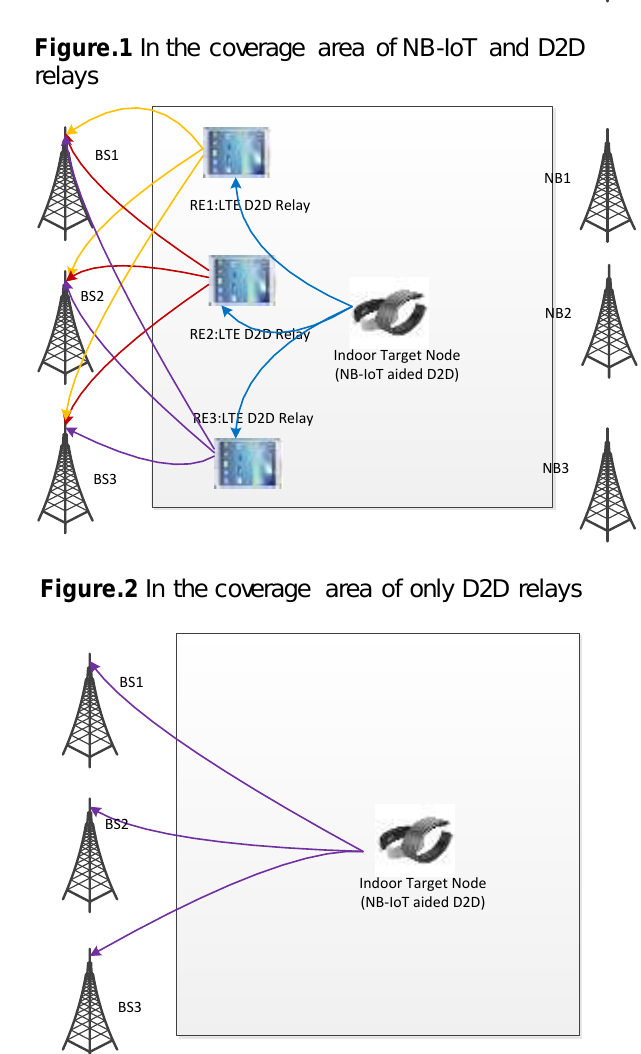
Figure.3 In the coverage area of LTE Macro